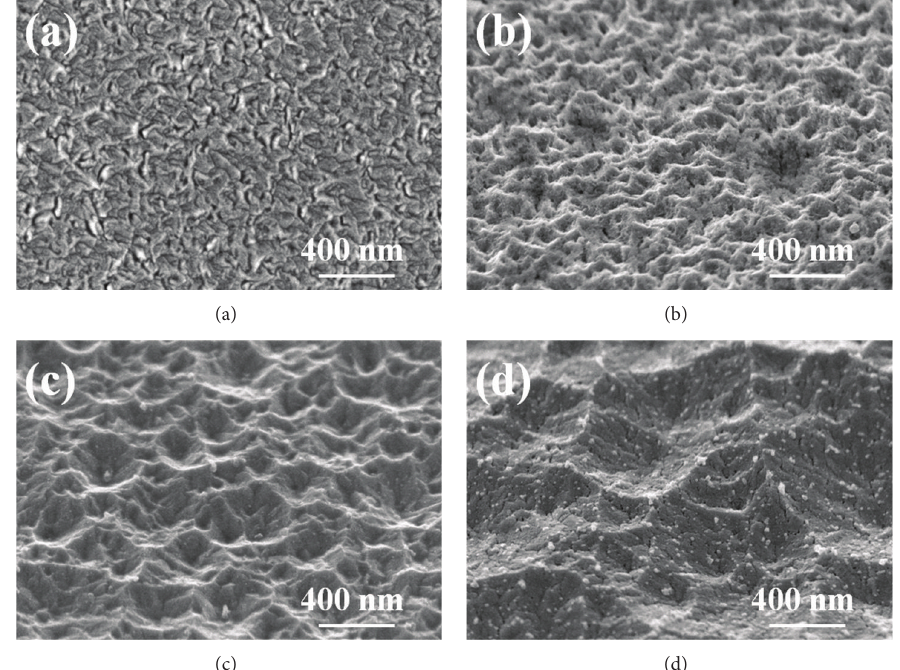
Figure 5: Surface morphology of the FZO thin films (a) as-deposited and etched at different HCl concentrations (b) 0.1%, (c) 0.2%, and (d) 0.5%,